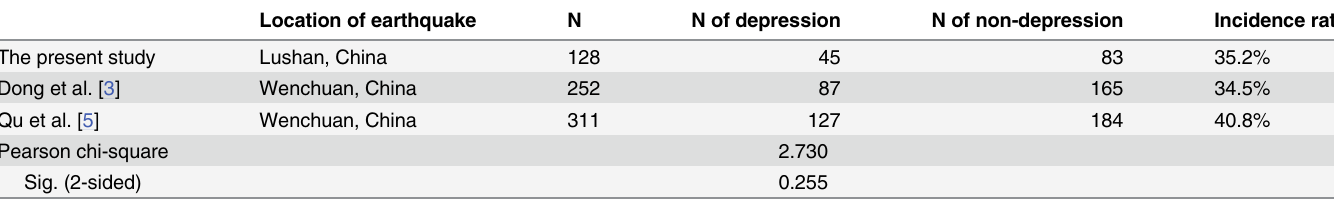
Table 1. Incidence rate of prenatal depression in different studies. Location of